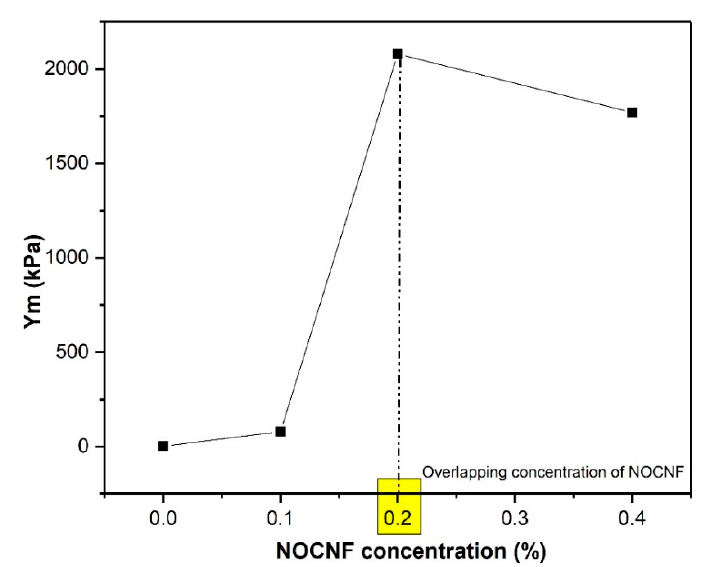
Figure 7. Graph represents the relationship between the Young’s modulus (kPa) and the NOCNF concentration in the composite films.